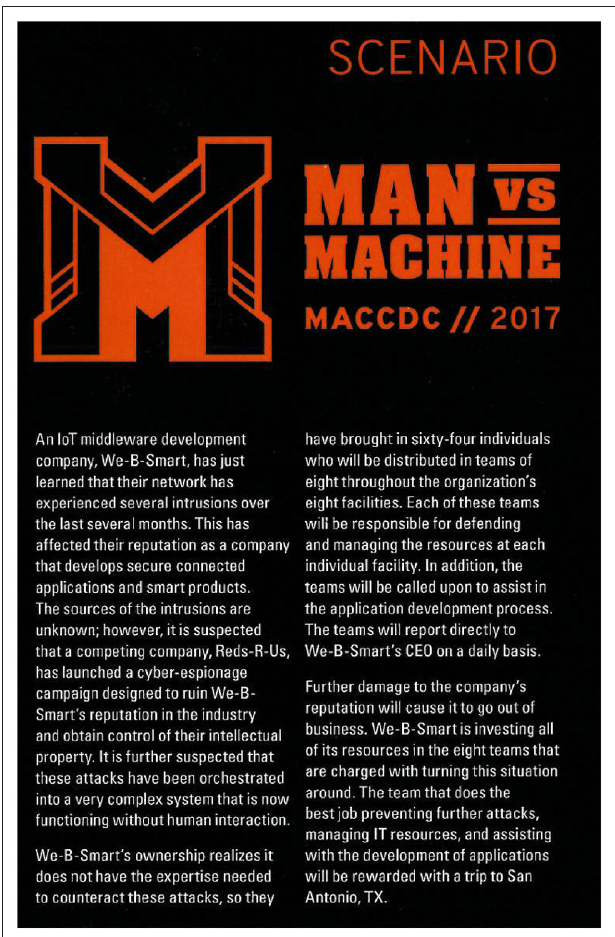
FIGURE 2 | “Man vs. Machine” Internet-of-Things scenario description given to